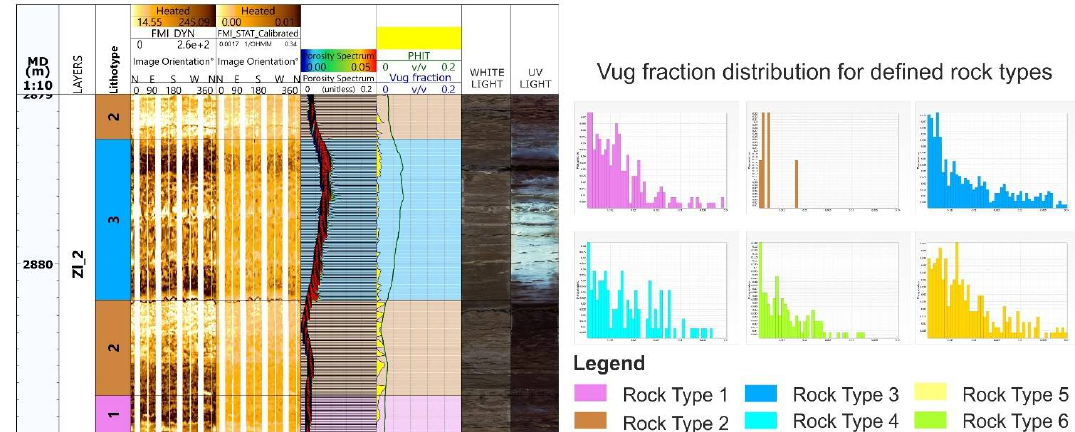
Figure 8. Vug fraction histogram with corresponding well-log template. Total porosity, PHIT, is derived from well logs. Distribution of vug fraction is obtained for each rock type, which was defined using core, FMI, and log data.